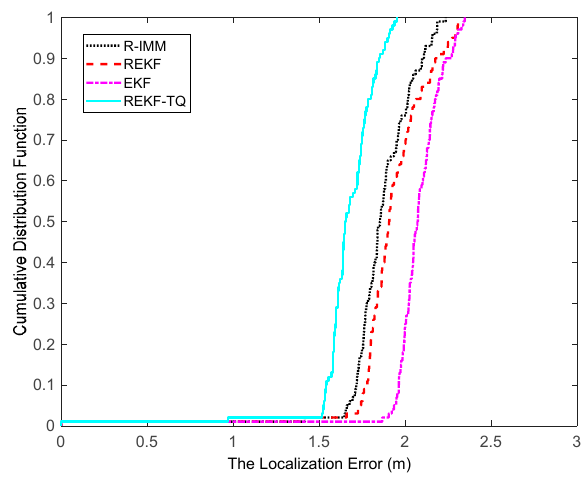
Figure 13. The localization error CDF.